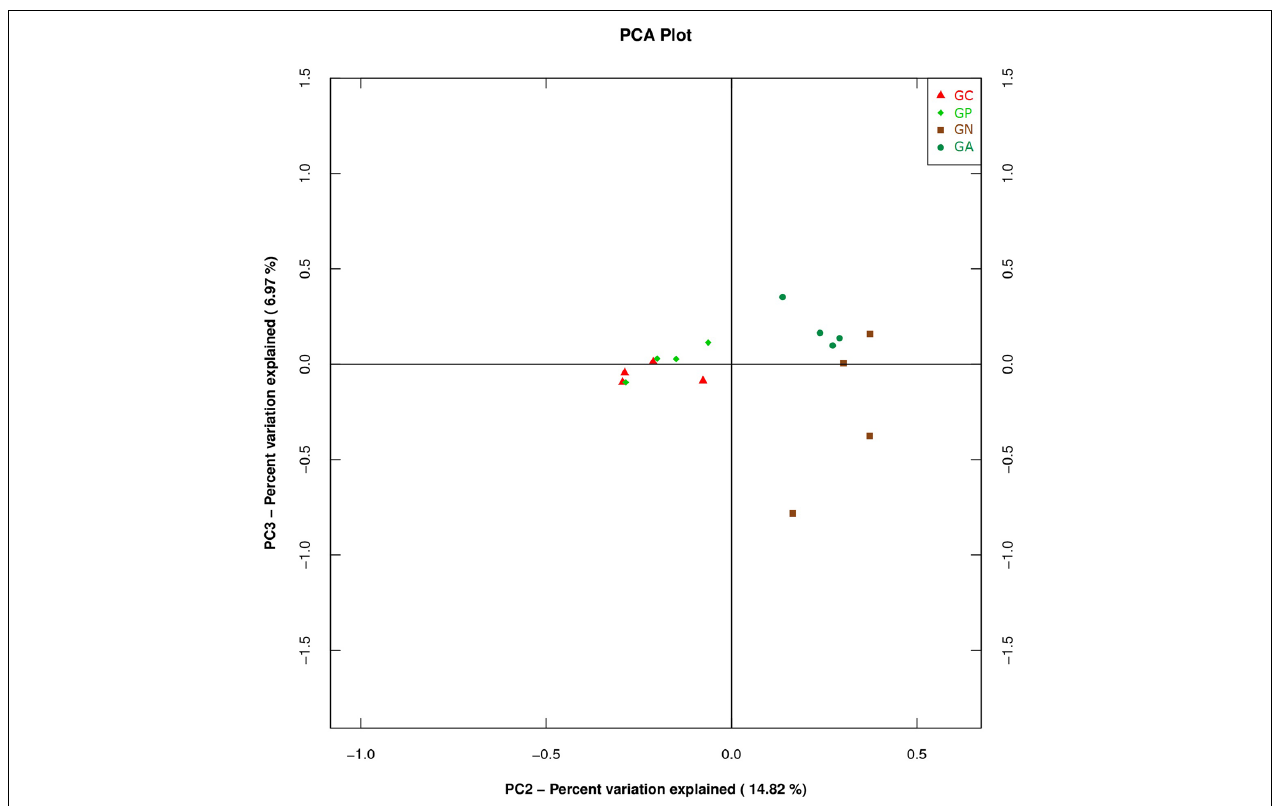
FIGURE 4 | Principal component analysis (PCA) plot based on the second and third PC of bacterial community taxonomic profiles from 16 mixed cecal samples in four groups. GC, control group; GP, phage-therapy group; GN, negative control group N; GA, antibiotic-therapy